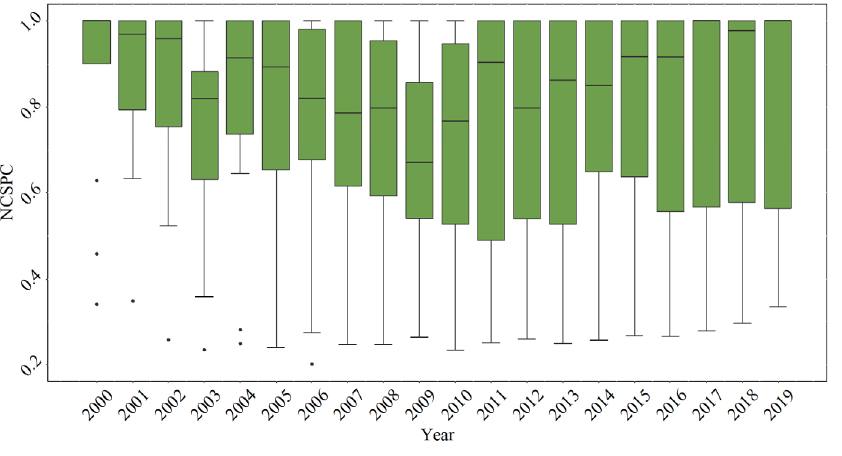
Figure 6. Box plot of the NCSPC in the principal grain-producing area of China from 2000 to 2019.